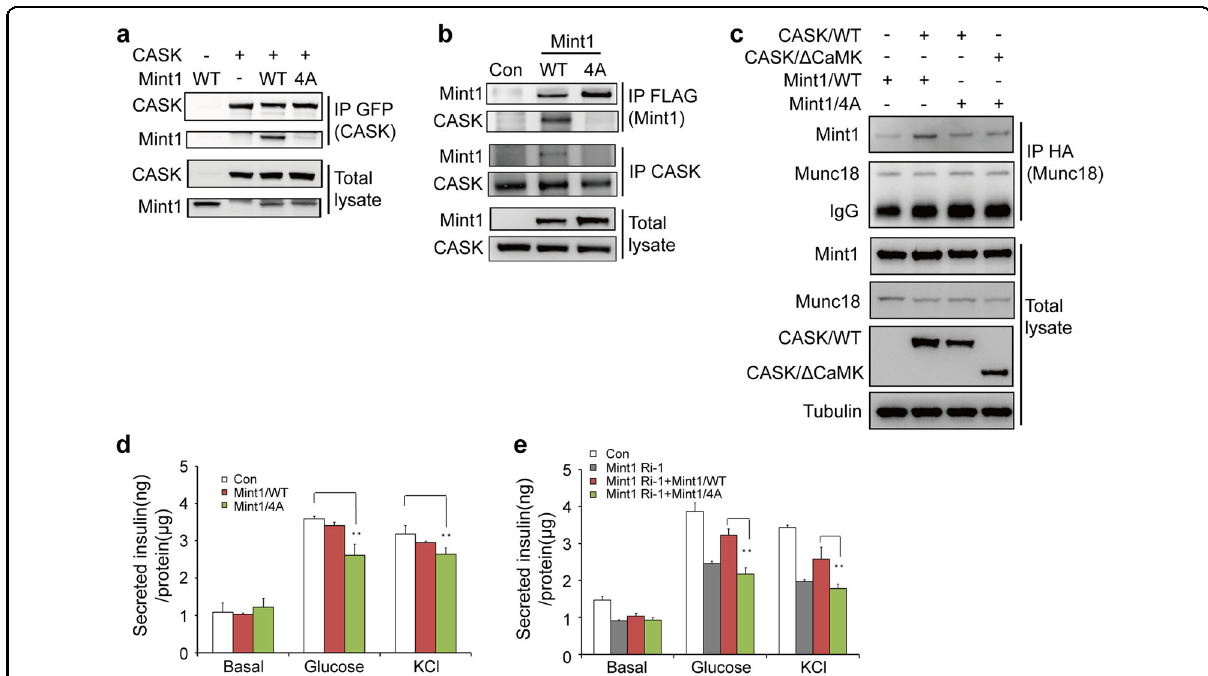
Fig. 6 CASK-Mint1 interaction regulates insulin secretion. a Co-immunoprecipitation of exogenous CASK, Mint1 and Mint1/4A muntant in 293 cells. b Co-immunoprecipitation of CASK and Mint1 in glucose-stimulated INS-1E cells that were transfected with empty vector (Con), Mint1/WT or Mint1/4A mutant. c Co-immunoprecipitation of exogenous Munc18-1 and CASK in 293 cells. Mint1/WT or Mint1/4A mutant, CASK/WT or △ CaMK mutant and Munc18-1 were overexpressed in 293 cells as indicated. d Overexpression of Mint1/4A mutant inhibited insulin secretion in INS-1E cells. e Reduced insulin secretion due to RNAi targeting Mint1 (Ri-1) could be rescued by siRNA-resistant wild type Mint1 (Ri-1 + WT) but not the mutant (Ri-1 +